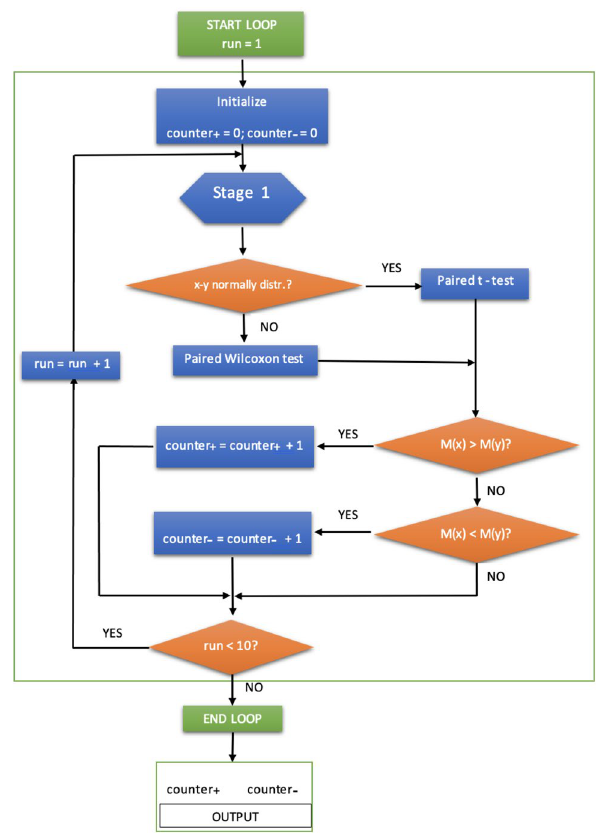
Figure 3. Implementation: Stage 2 procedure flowchart covering the Stage 1 architecture shown in Fig. 2. The letter “M” in the decision boxes denotes the mean/average or the median, depending on whether or not the normality of the distribution of the sample x − y can be assumed, respectively, where x and y are the output of Stage 1 (Fig.